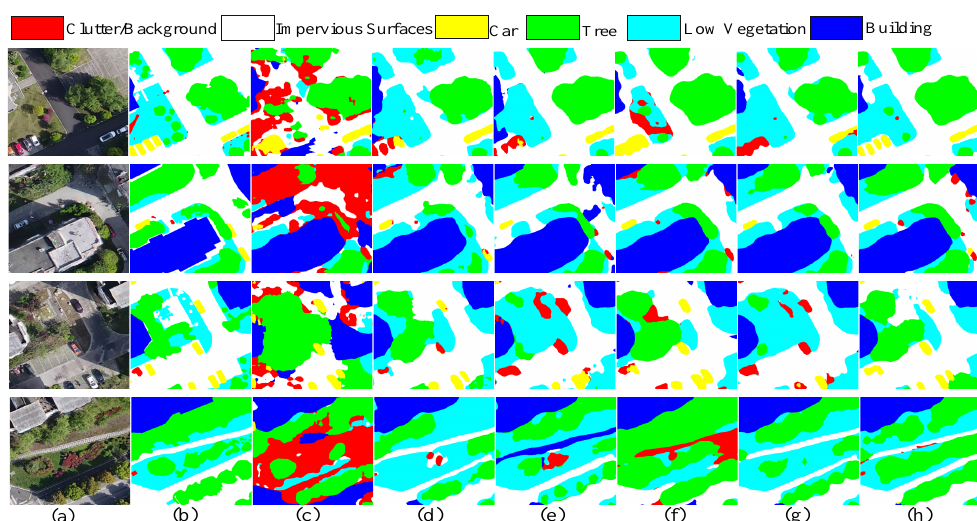
Figure 6. The qualitative results of the cross-domain semantic segmentation from PotsdamIRRG to BC403. ( a ) Target images. ( b ) Labels. ( c ) Baseline (DeeplabV3 [43]). ( d ) Benjdira’s [26]. ( e ) Dual- GAN [33]. ( f ) AdaptSegNet [18]. ( g ) MUCSS [12]. ( h ) ResiDualGAN + OSA (ours).